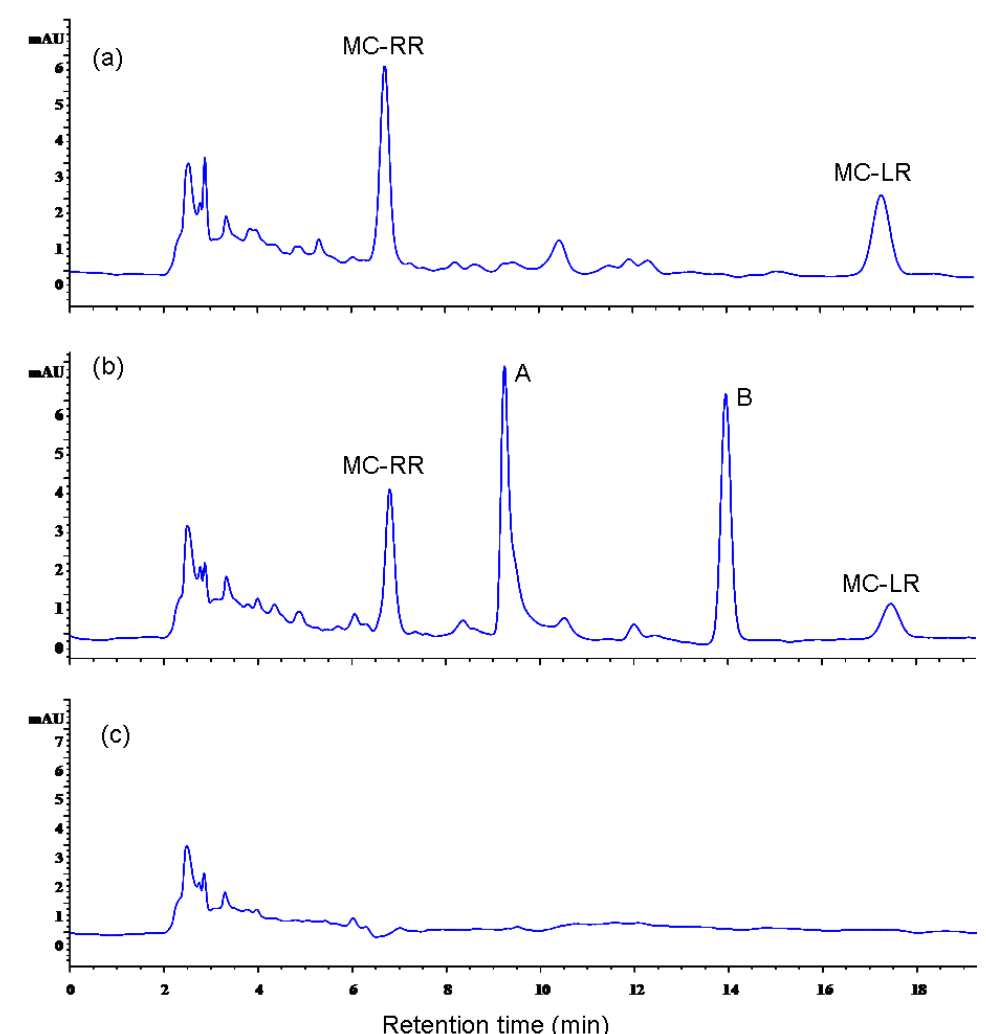
Figure 7. HPLC chromatograms at time zero (a), 12 h (b), and 24 h (c), illustrating degradation of MC-LR and MC-RR incubated with